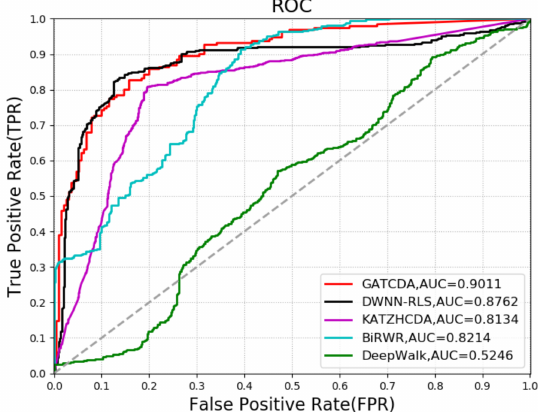
Figure 4. The ROC curves and AUCs of five methods using